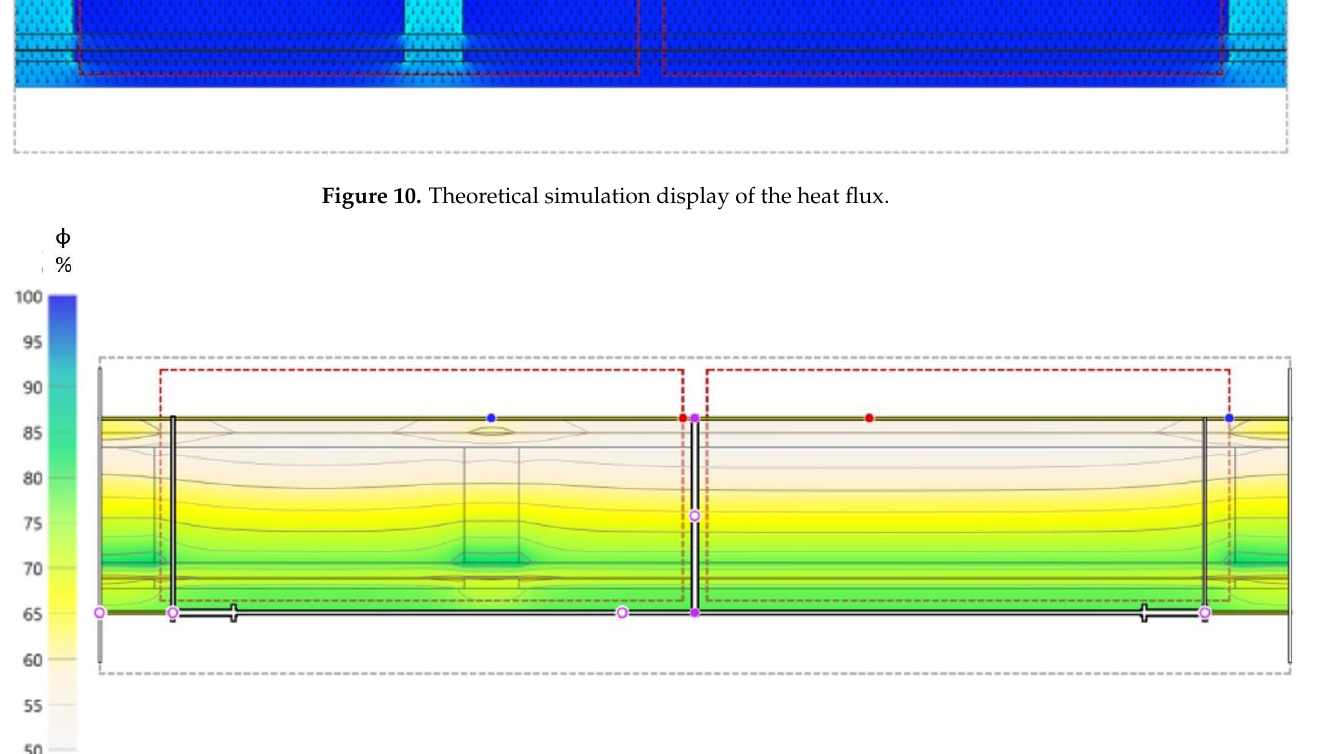
Figure 11. Theoretical simulation display of the humidity.